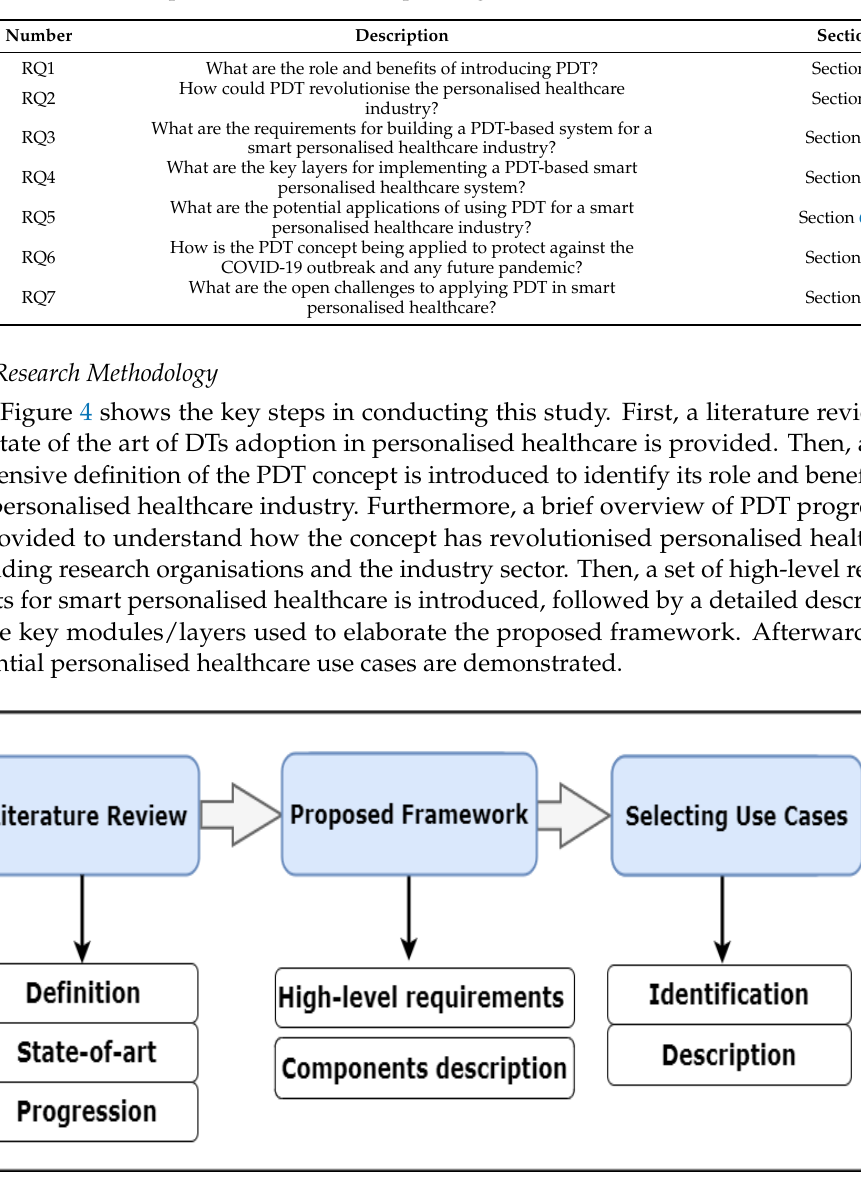
Table 3. The research questions and the corresponding section/subsection for the answer.